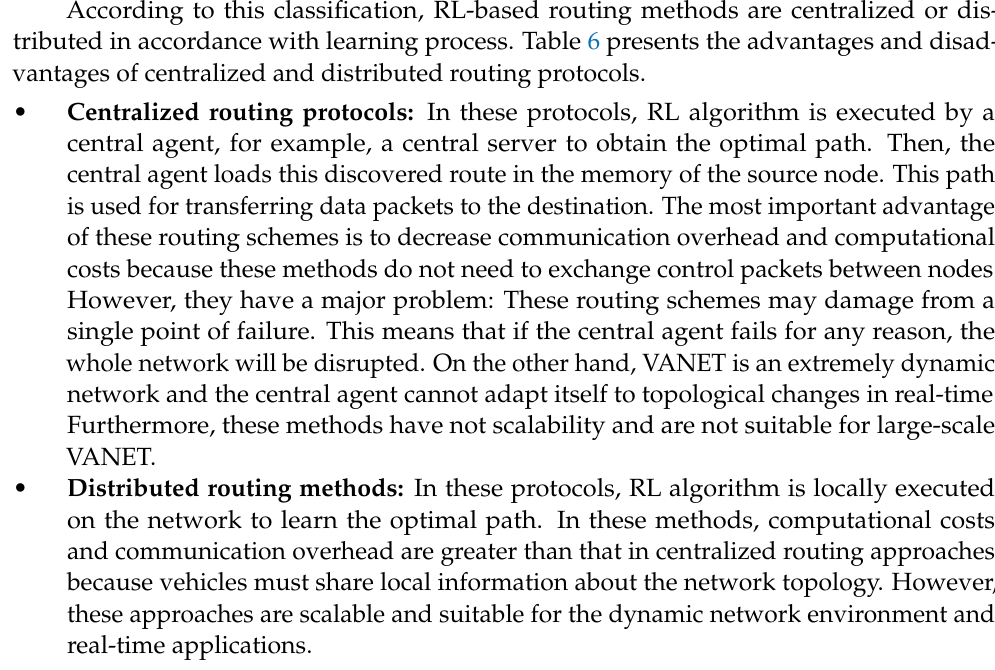
Table 6. Centralized and distributed routing